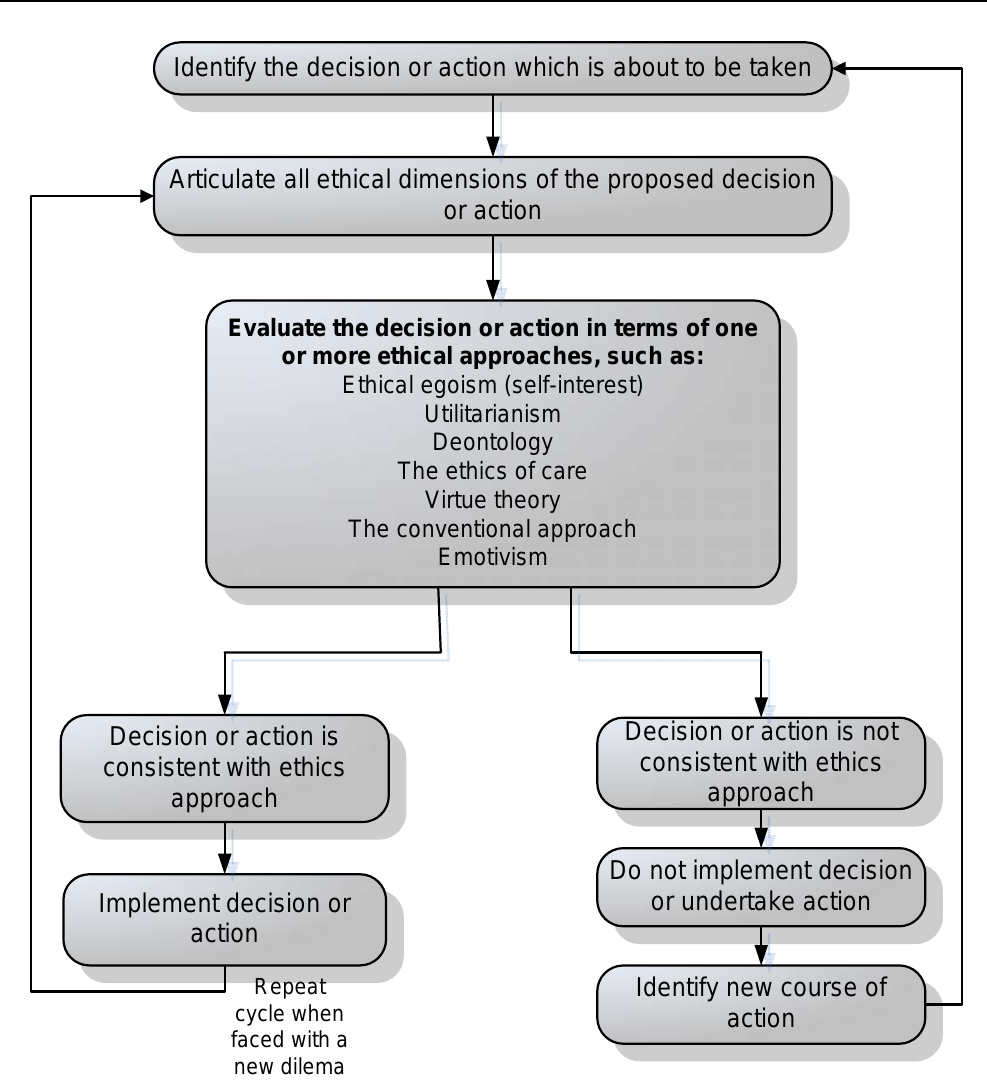
Figure 2: A generic model of ethical decision making Source: Adapted from Carroll and Bucholtz